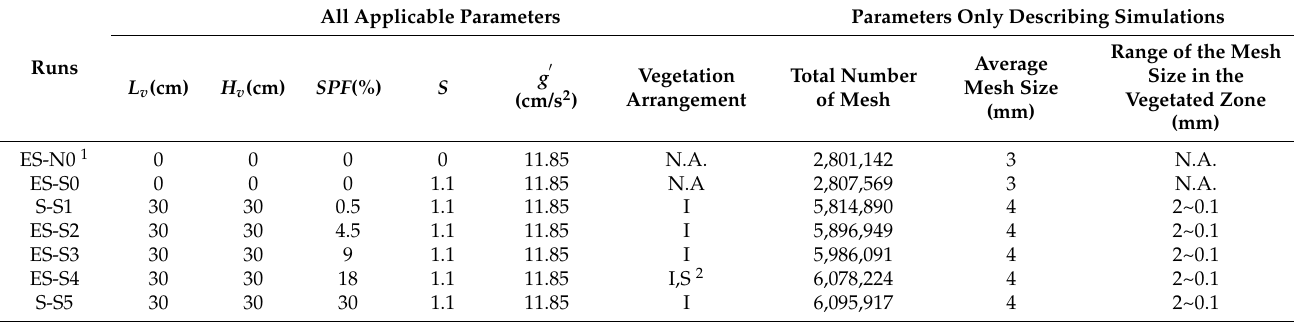
Table 1. Parameters of the experimental and numerical